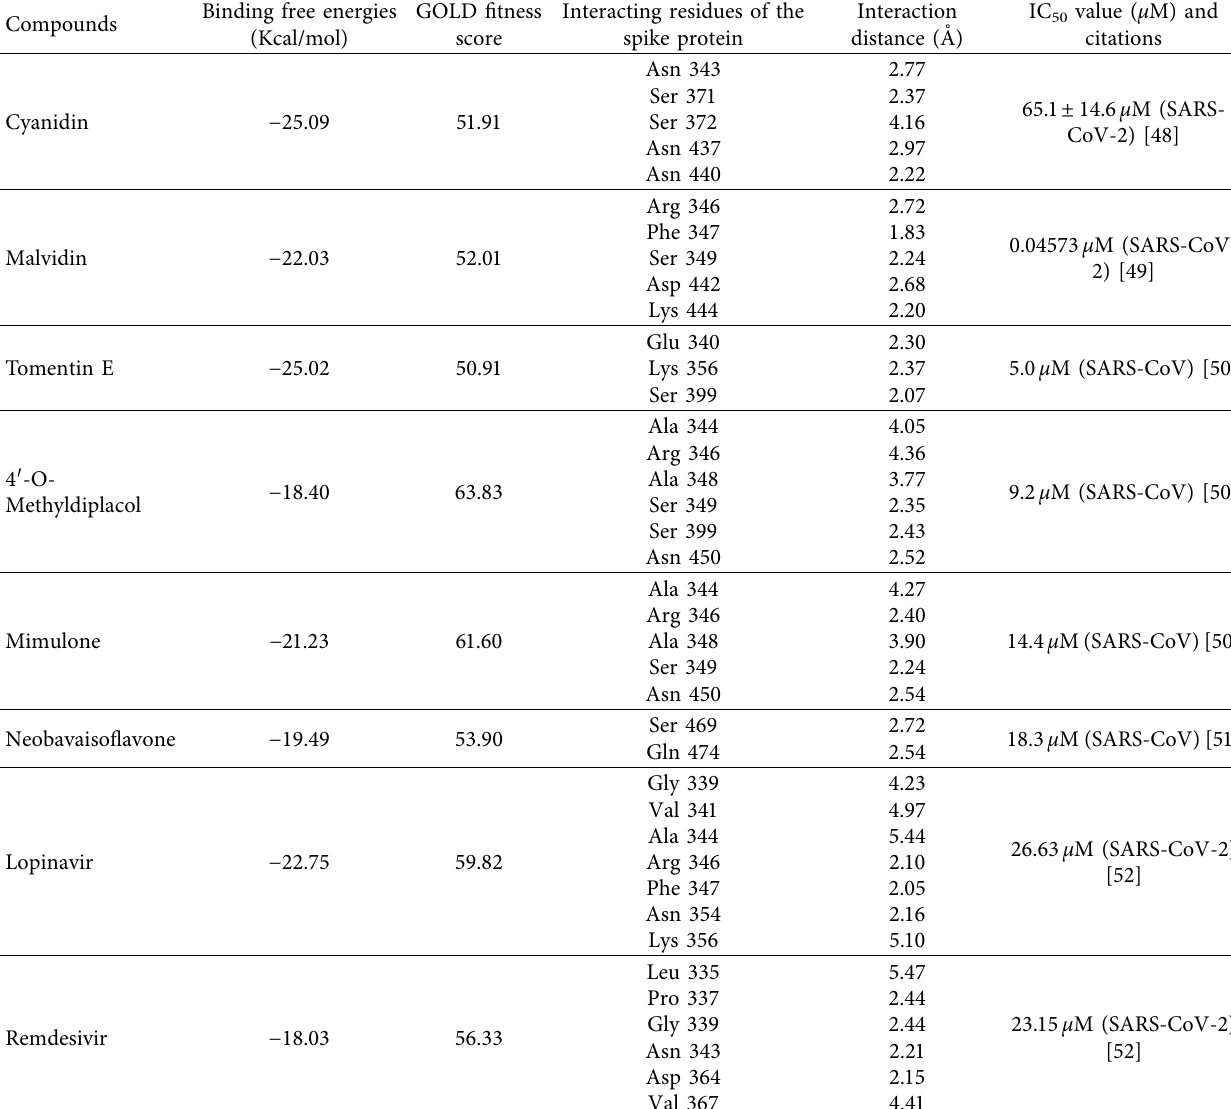
Table 4: Binding free energies, GOLD ftness score, interacting residues of spike protein with their interaction distance, and IC potent metabolites which were obtained from previous studies through in vitro